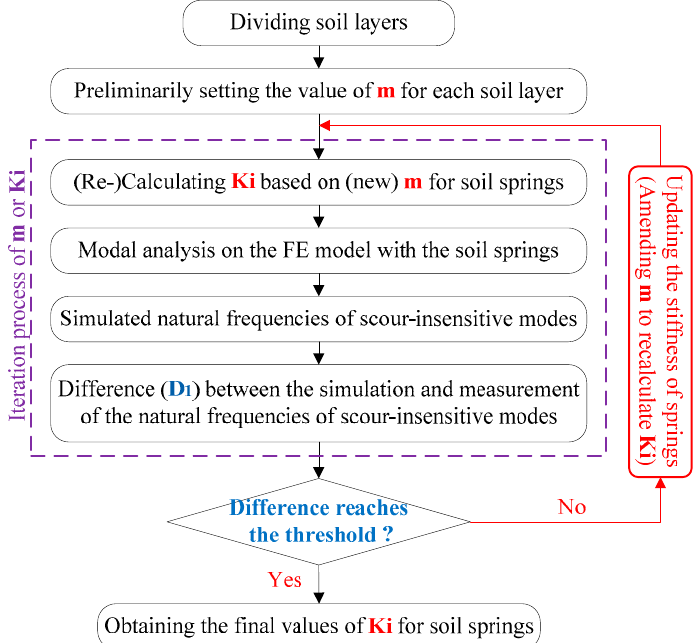
Figure 14. Algorithm for identifying soil sti ff ness.